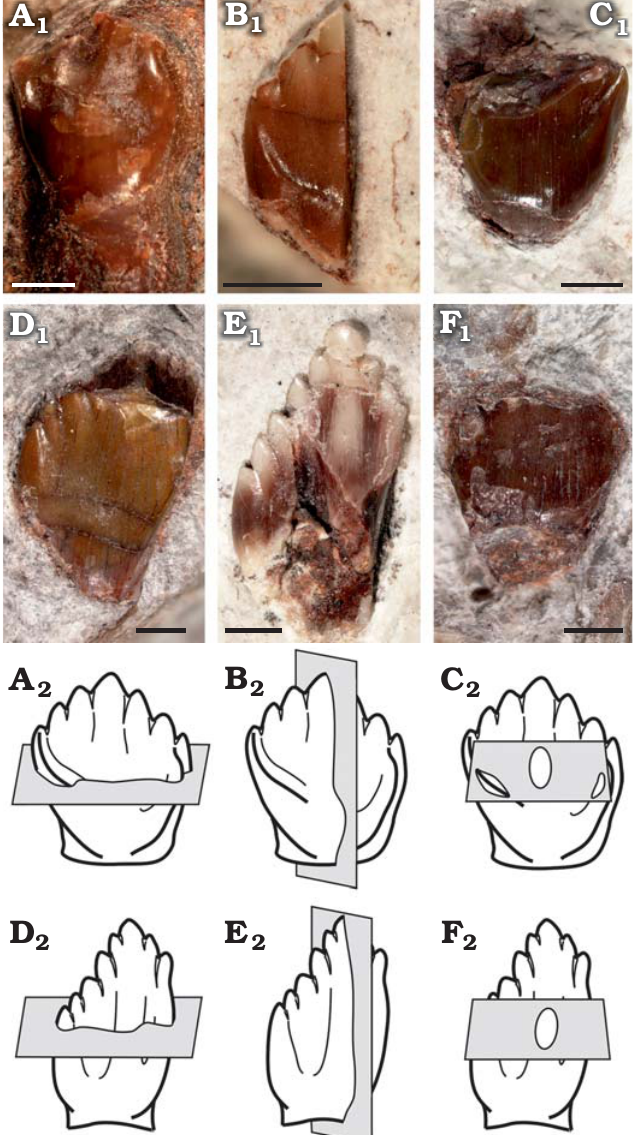
Fig. 1. Sectioned isolated teeth of a basal ornithischian Manidens condoren- sis Pol, Rauhut, and Becerra, 2011 from Cañadón Asfalto Formation (Queso Rallado locality, late Toarcian), Chubut province, Argentina. A . MPEF-PV 3821. B . MPEF-PV 10823. C . MPEF-PV 10864. D . MPEF-PV 10863. E . MPEF-PV 10862. F . MPEF-PV 10865. In labial (A–D) and